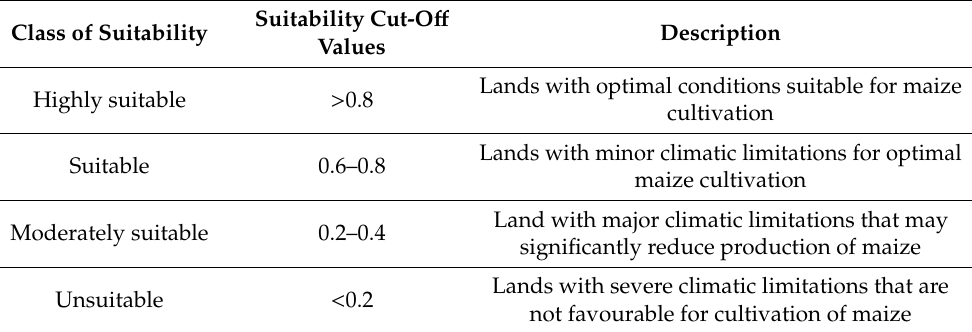
Table 1. Suitability assessment for maize cultivation in